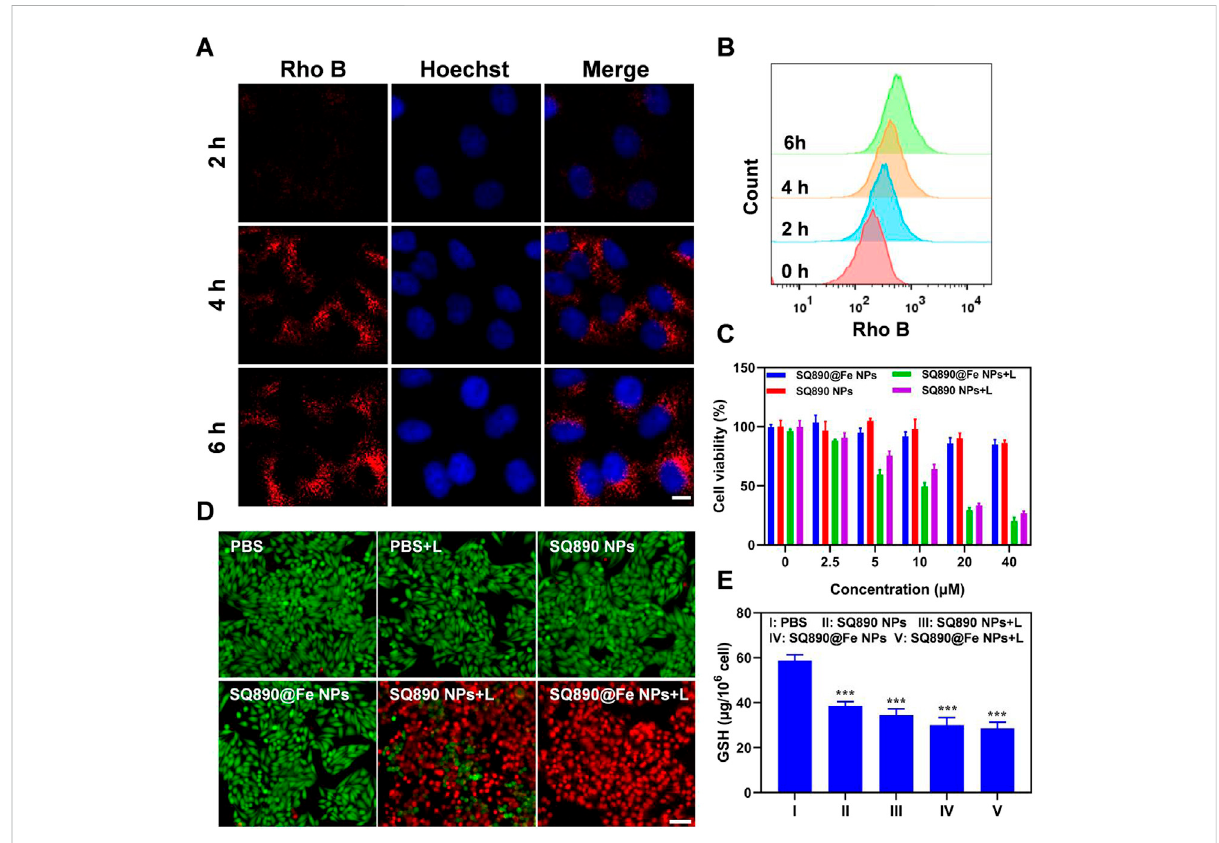
Cellular uptake and cytotoxicity to HepG2 cells. (A,B) Cellular internalization of nanoparticles labeled with Rho B observed by CSLM (A) and quantitativeanalysisby fl owcytometry (B) .Scalebar:10 μ m. (C) ViabilityofHepG2cellsaftertreatedwithdifferentconcentrationsofSQ890@FeNPs or SQ890 NPs in dark or under 808 nm laser illumination. (D) Live/dead stained by PI and calcein AM of HepG2 cells after various treatments. (E) The GSH in HepG2 cells after various treatments (*** p < 0.001 versus PBS, n =